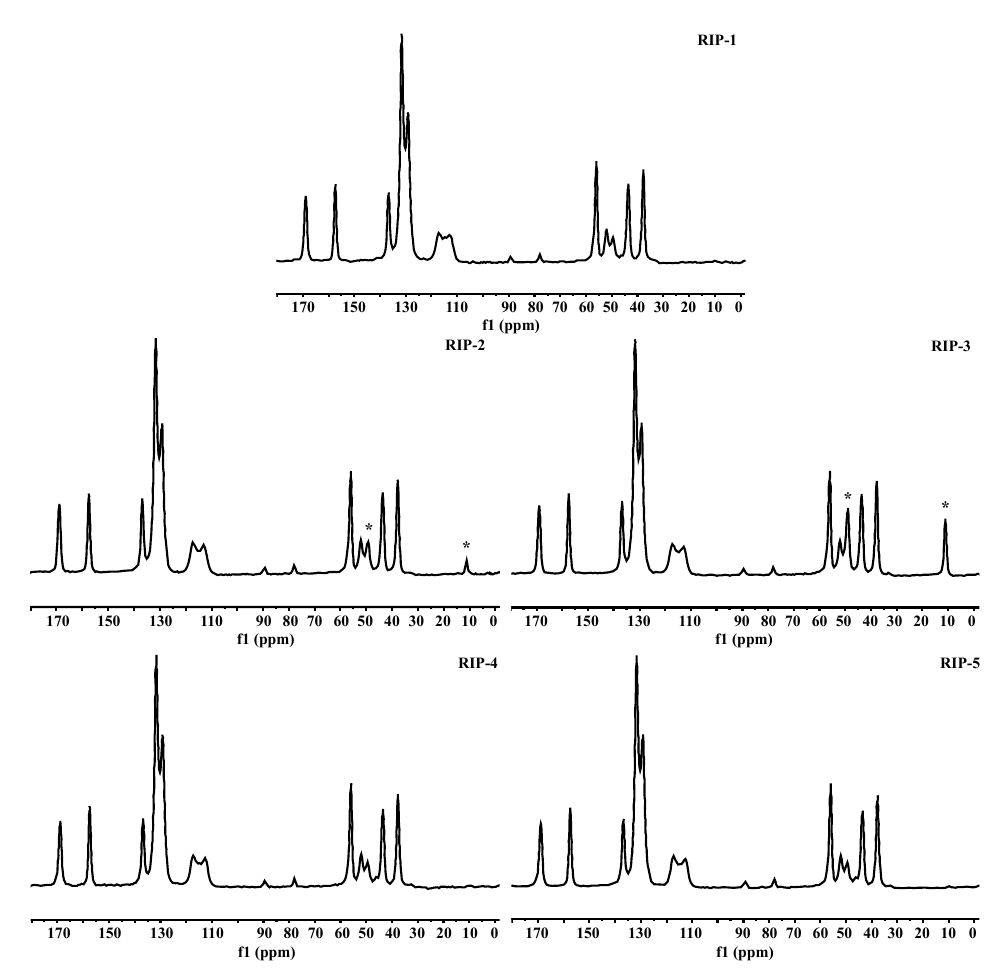
Figure 8. Solid-state 13 C-NMR spectra of riparin I physical forms. The (*) show characteristic peak corresponding of triethylamine.